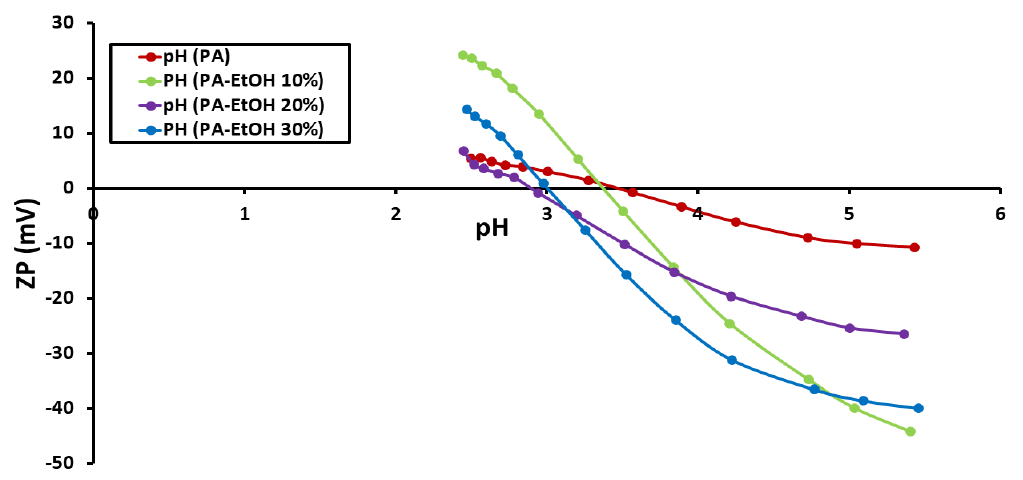
Figure 6. Zeta potentials of PA and PA and PA-EtOH (10%, 20%, and 30%) membranes as a function of pH.